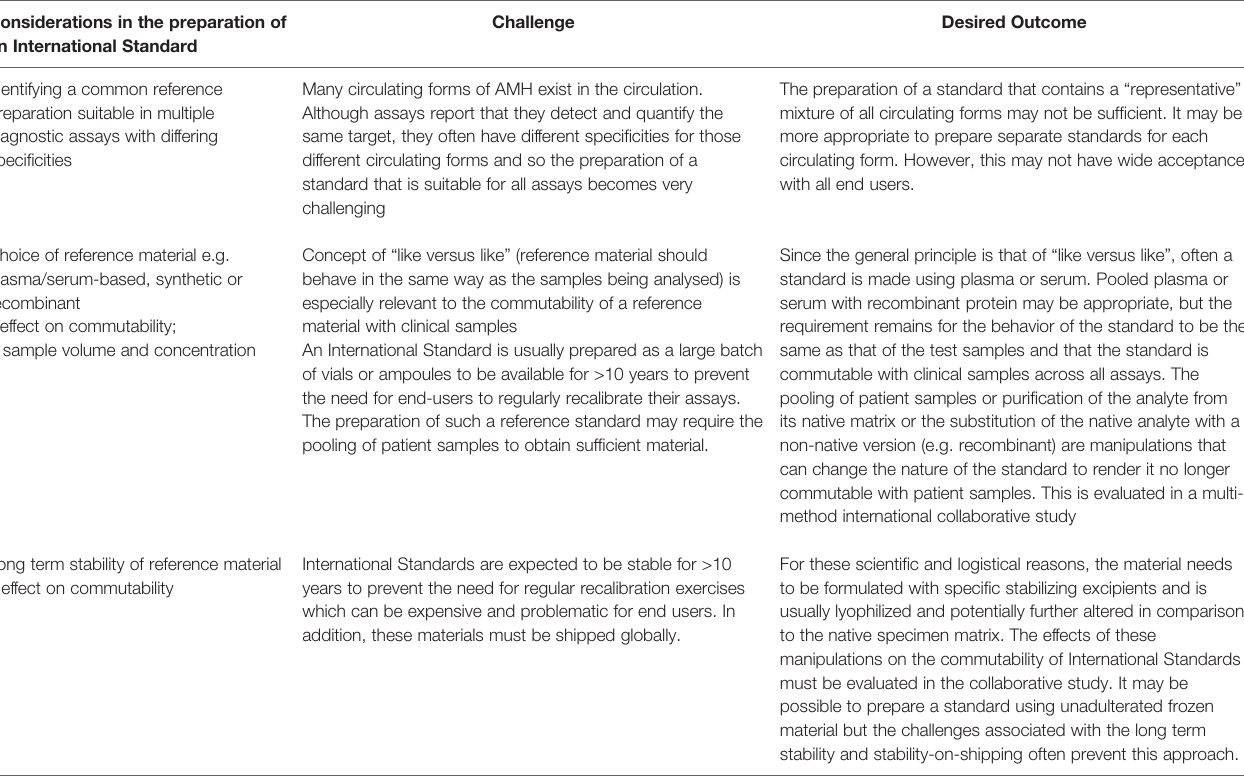
TABLE 2 | Challenges in creating a valid International reference